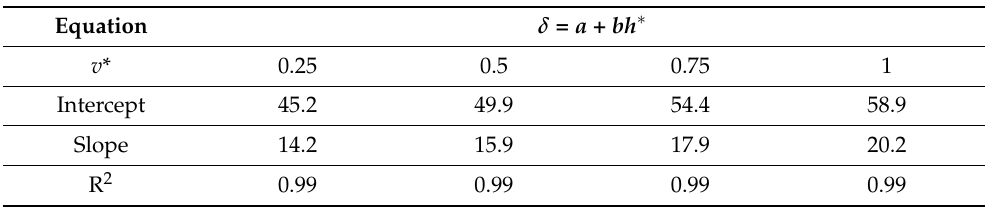
Table 2. Results between δ and v * (when h ≤ 1.4 m ( h * ≤ 0.5)).